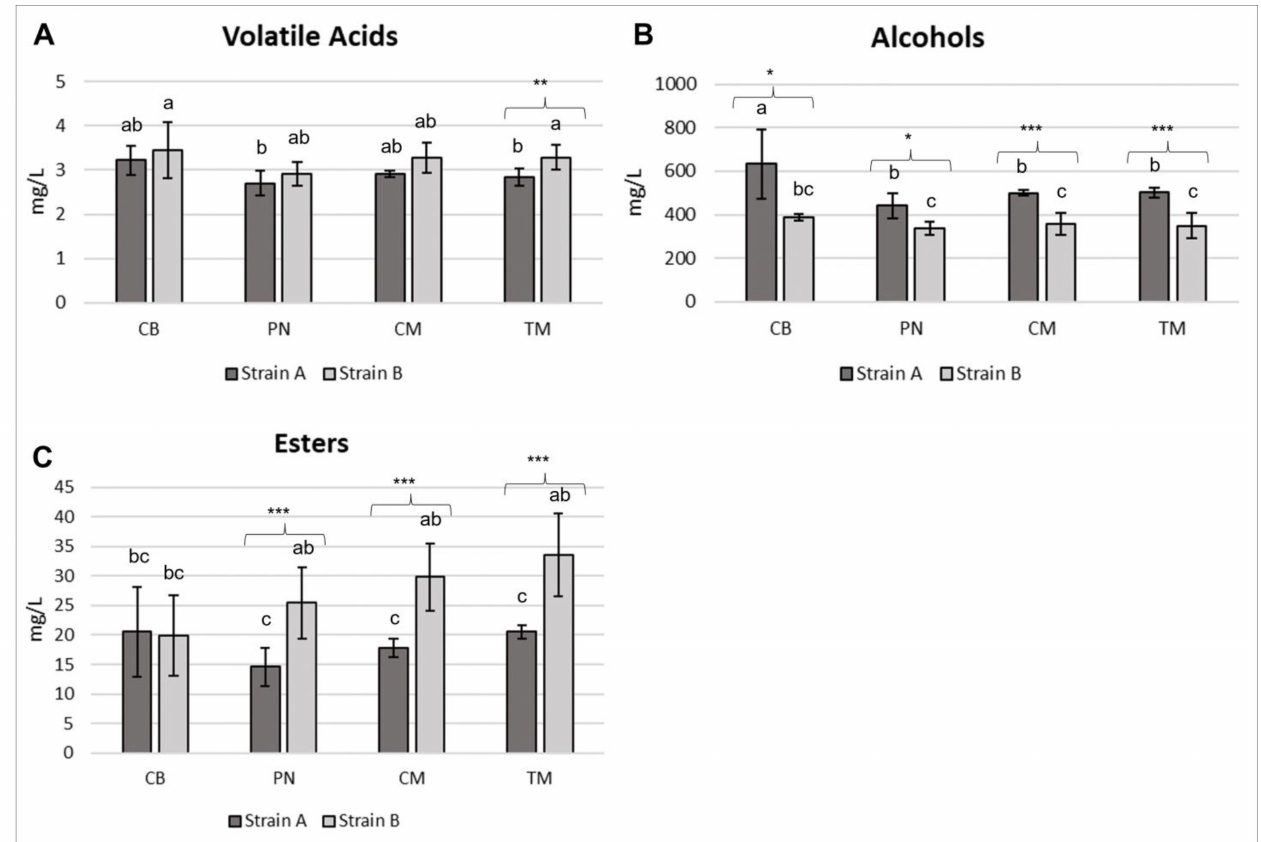
Figure 4. Sum of volatile ( A ) alcohols, ( B ) acids, and ( C ) esters measured in base cider (Cider), P é t-Nat, pressured-tank Charmat method (Charmat), and traditional bottle-fermented cider (Cham- penoise) inoculated with Torulaspora delbrueckii strain A or strain B. Data are reported as average and error bars indicate the standard deviation. Differences between strains for method are indicated as (***): significant at p < 0.001, (**): significant at p < 0.01, and (*): significant at p < 0.05. Different letters identify significant differences ( p <